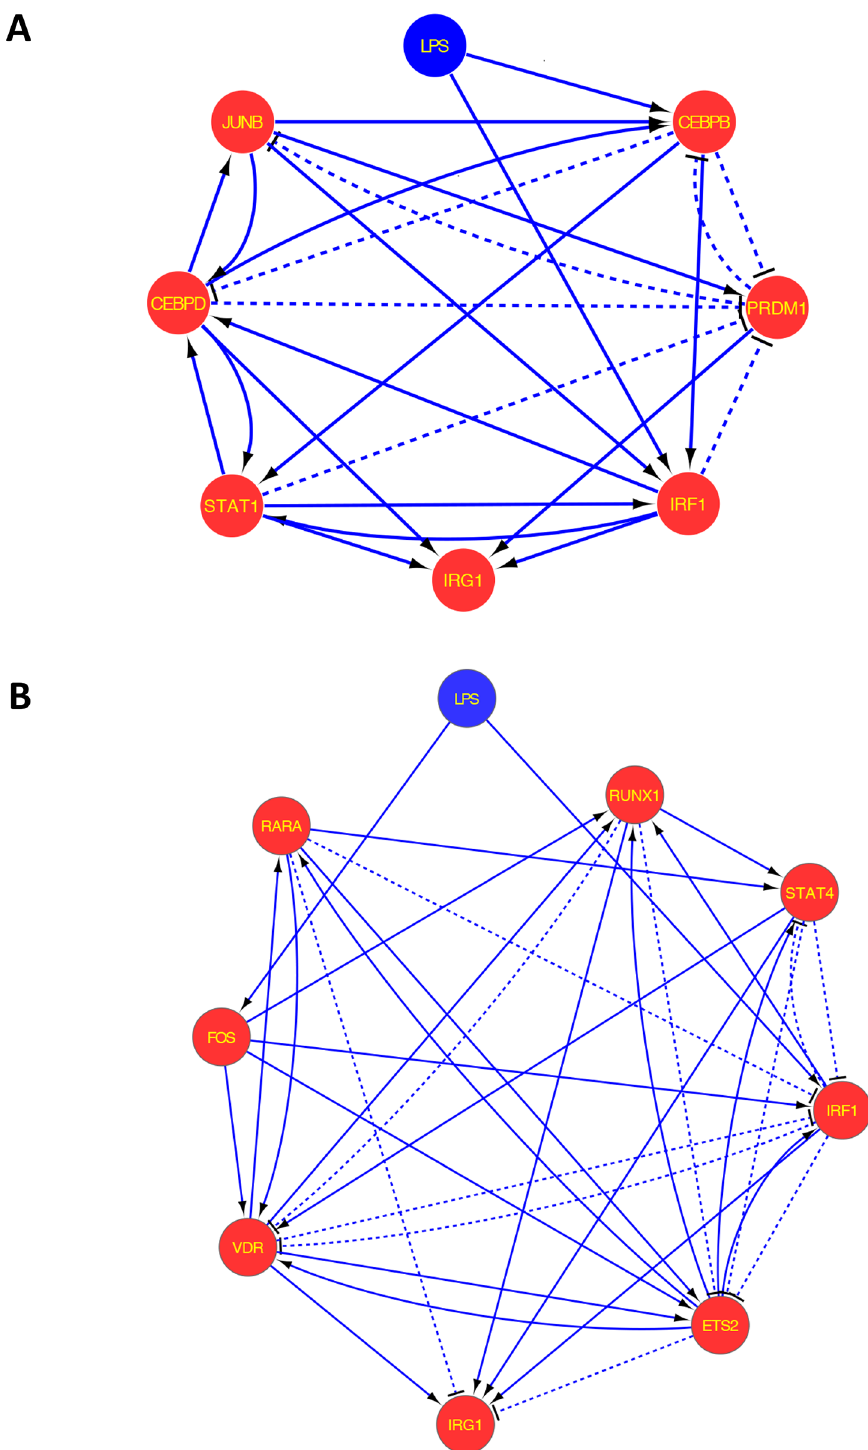
Fig 5. All possible paths from LPS to IRG1 from the contextualised network. ( A ) Mouse and ( B ) human networks hierarchical layouts after calculating all possible paths between LPS and IRG1 from the contextualised networks. IRF1 , interferon regulatory factor 1; CEBPB, CCAAT/enhancer binding protein (C/ EBP) beta; CEBPD, CCAAT/enhancer binding protein (C/EBP) delta; STAT1, signal transducer and activator of transcription 1; JUNB, Jun B proto-oncogene; PRDM1, PR domain containing 1 with ZNF domain; STAT4,